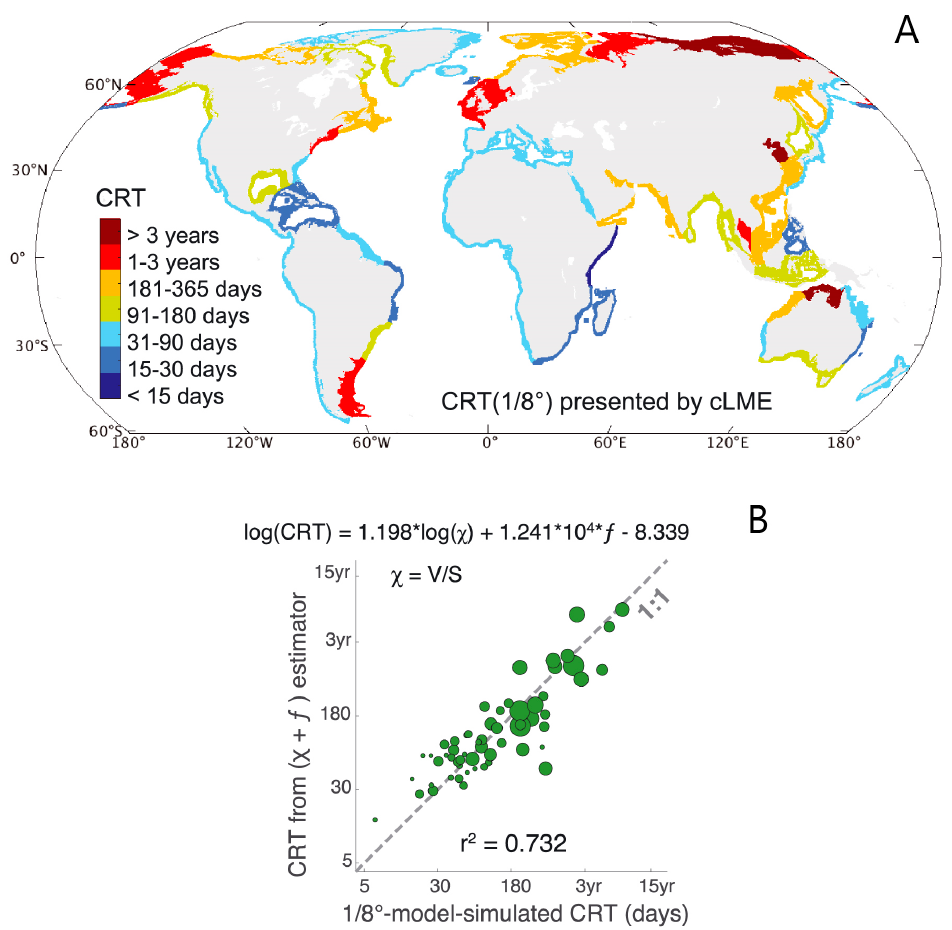
Figure 12. ( A ) A global map of coastal residence times (CRTs) simulated by Liu et al. [207] using high-resolution, coupled global ocean-ice models and a novel variation on an age tracer approach; ( B ) simple model of CRT as a function of Coriolis parameter f and a geometric parameter χ , which is the ratio of total coastal system volume to total open boundary area. (Modified with permission from Xiao Liu, Geophysical Research Letters; published by Wiley, 2019).